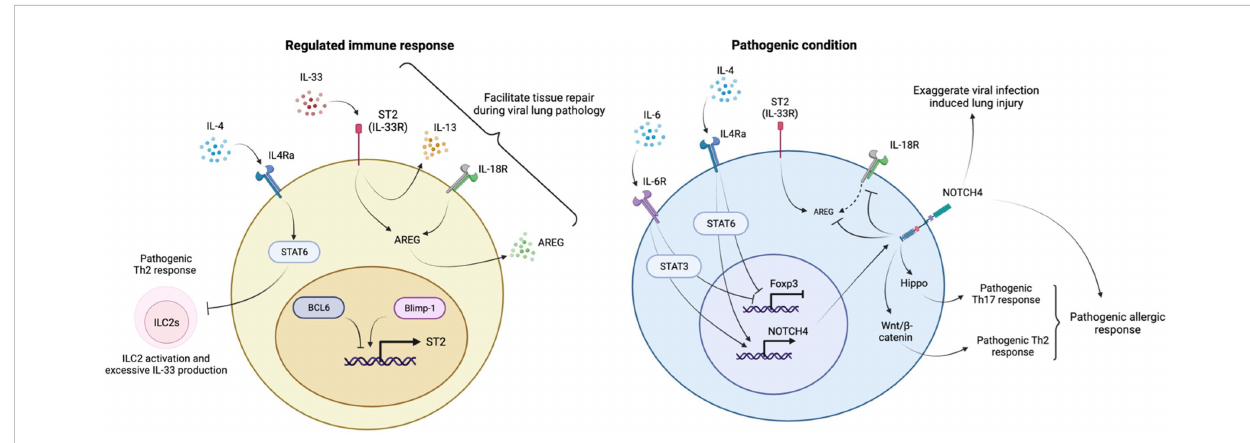
FIGURE 3 Regulation of lung homeostasis by lung Tregs. The IL-33-ST2 axis induces IL-13 and AREG to prevent in fl ammatory responses and facilitate tissue repair during respiratory viral infection. ST2 expression in lung Tregs is controlled under the balance between Blimp1 and BCL6. The IL4R-STAT6 pathway is necessary to keep ILC2s in check to prevent aberrant activation and excessive production of IL-33. Under in fl ammatory conditions, IL-4 and IL-6 suppress Foxp3 expression and induce NOTCH4 expression in lung Tregs. NOTCH4 enhances Th17 and Th2 pathogenic responses during allergic in fl ammation through activation of Hippo and Wnt/ b -catenin signaling respectively. NOTCH4 also suppresses IL-18R/AREG axis and reduce AREG production, leading to progressive viral infection mediated lung